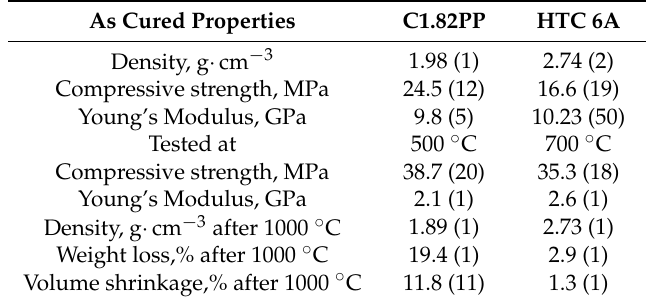
Table 3. Summary of in situ test results. Values in parentheses correspond to the least significant figure in the estimated standard deviation to the left.